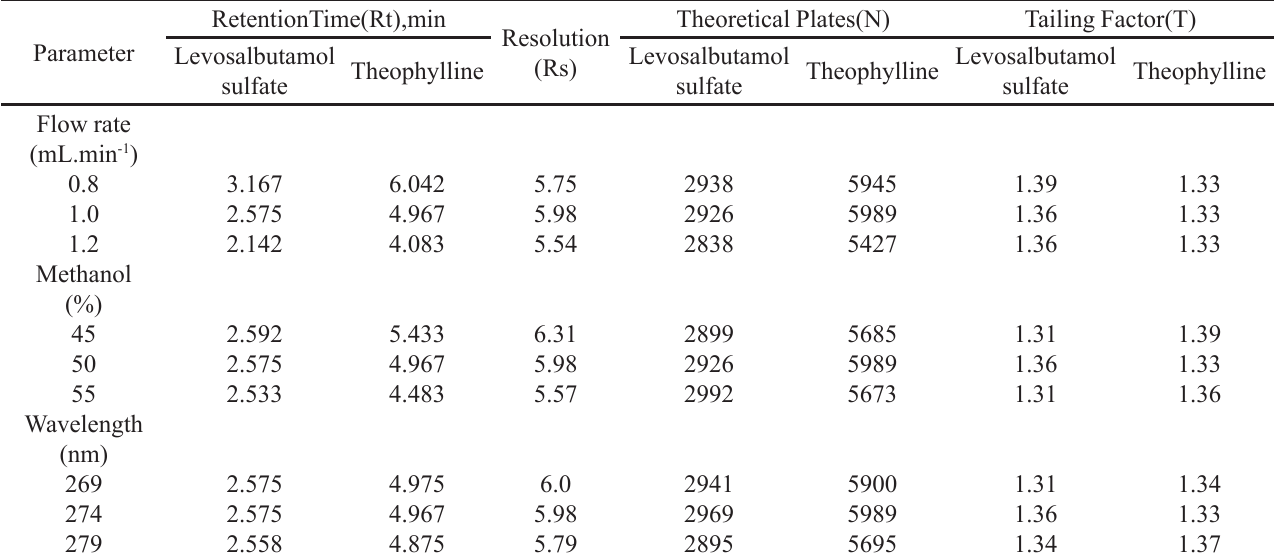
TABLE IV- Robustness of the method